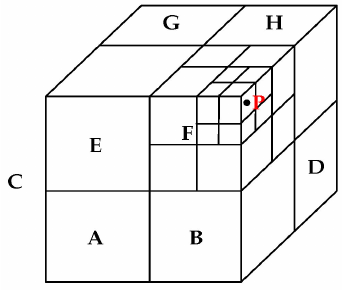
Figure 1. Schematic diagram of the octree partitioning structure.